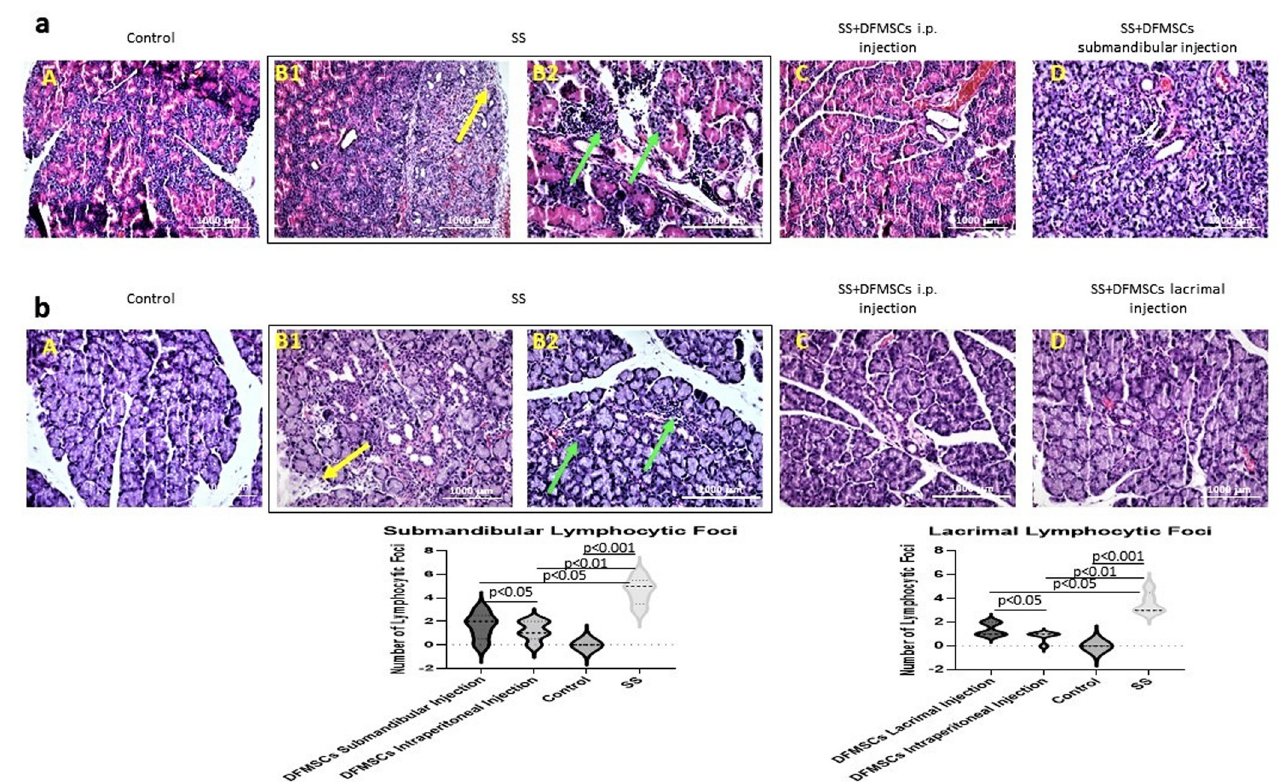
Fig 9. Histopathological analysis of glandular tissues. (a) Hematoxylin-eosin staining of submandibular and (b) lacrimal glands. The statistical analysis of lymphocytic foci of glandular tissues. Submandibular and lacrimal glands of SS mice showed high amounts of lymphocytic foci (Focus score > 1) compared to control subjects (Focus score < 1) (p < 0.001). The lymphocytic foci were shown with green arrows. Tissue destruction and fibrosis in submandibular and lacrimal glands in Group 2 were observed in the glandular sections (yellow arrows). DFMSCs significantly reduced lymphocytic infiltrates in submandibular glands (p < 0.01) and in lacrimal glands (p < 0.05), and ameliorated tissue destruction when applied intraperitoneally. Submandibular or lacrimal injection of DFMSCs significantly reduced lymphocytic infiltration and fibrosis in submandibular (p < 0.05) or lacrimal glands (p < 0.05).